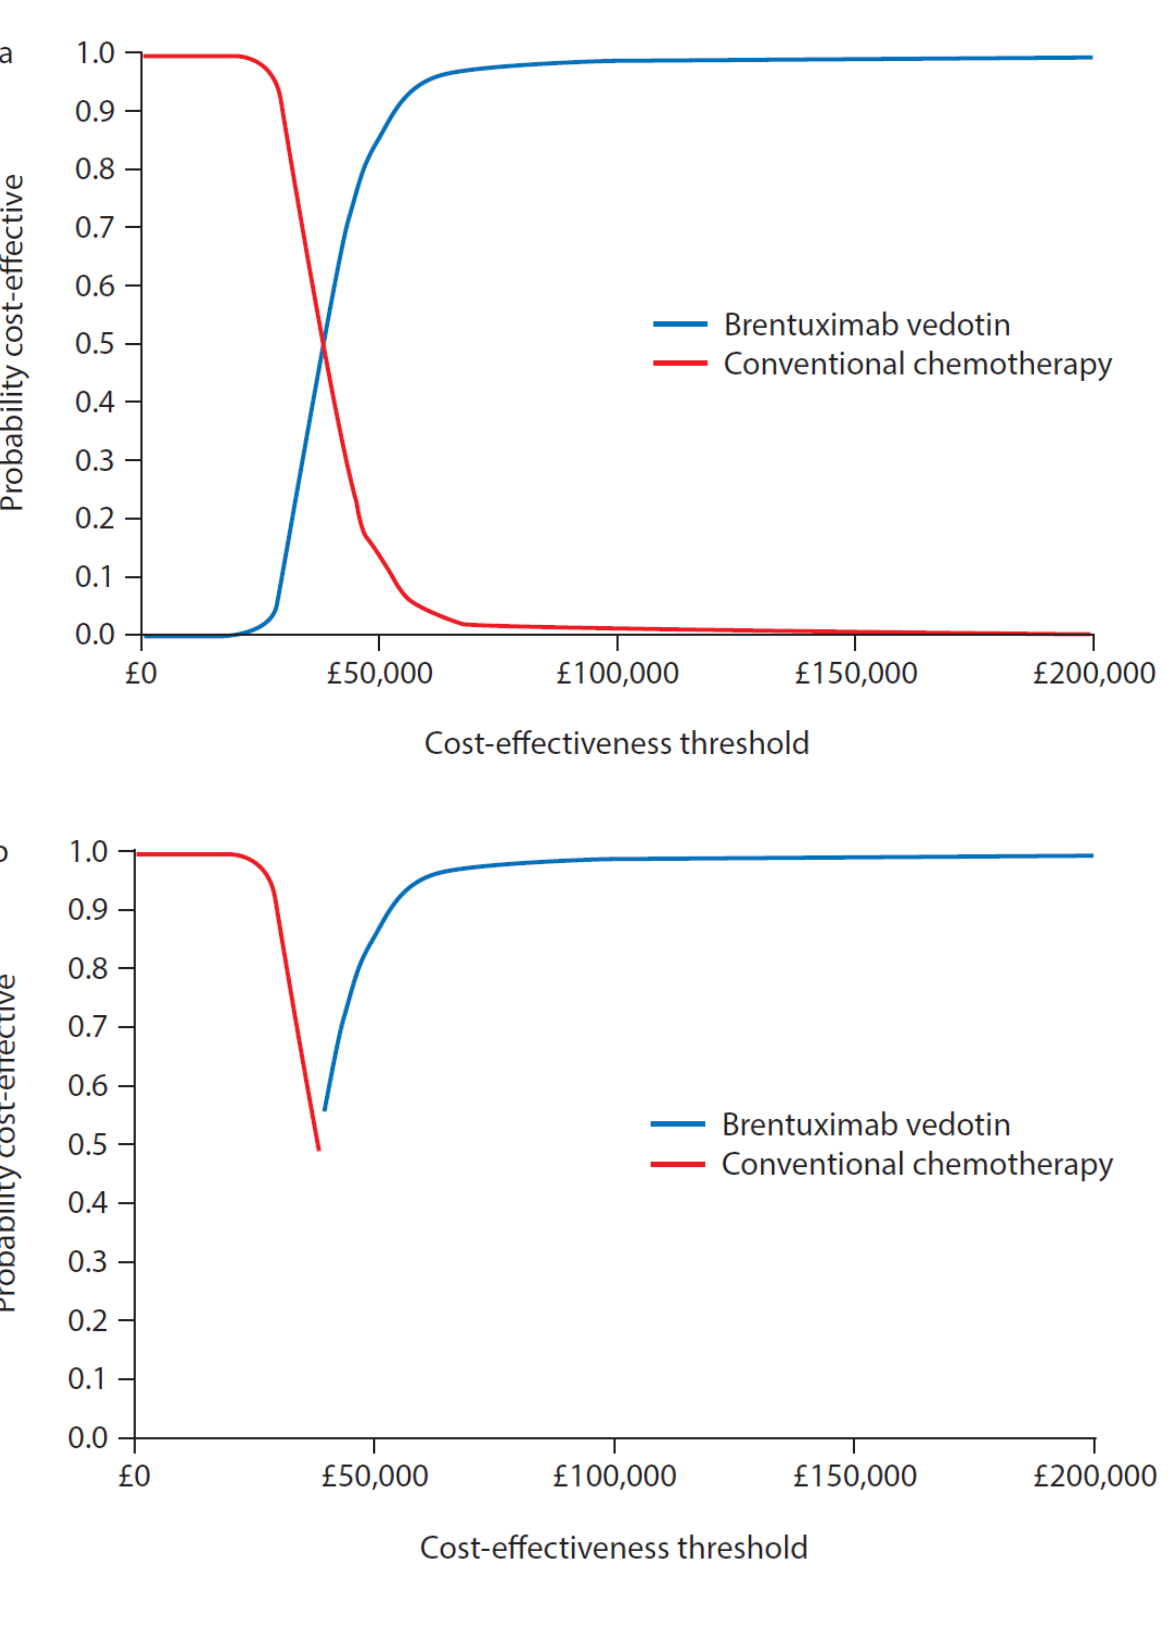
Figure 3. Probability of Cost-effectiveness of Brentuximab Vedotin or Conventional Chemotherapy. (a) Cost-effectiveness Acceptability Curves; (b) Cost-effectiveness Acceptability